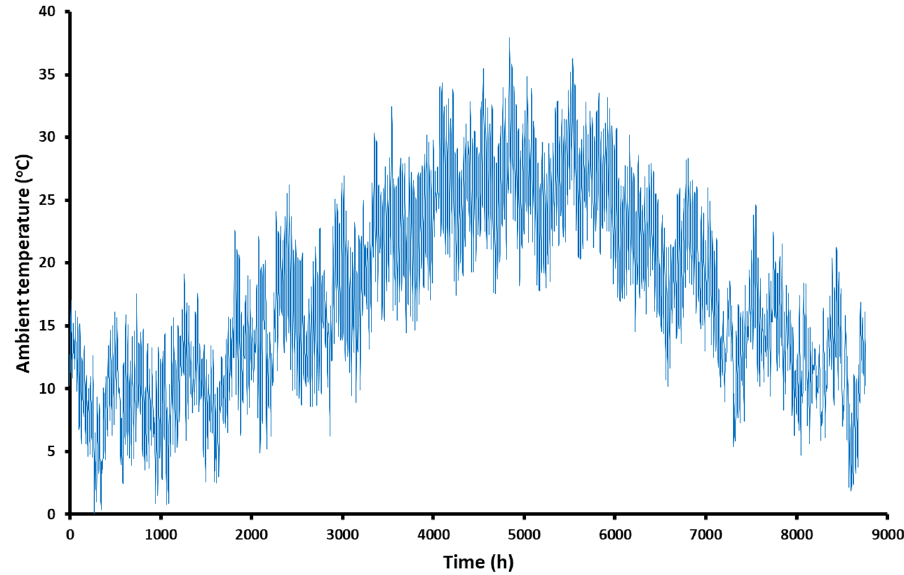
Figure 3. The environment temperature variation for the studied location (Athens, Greece).